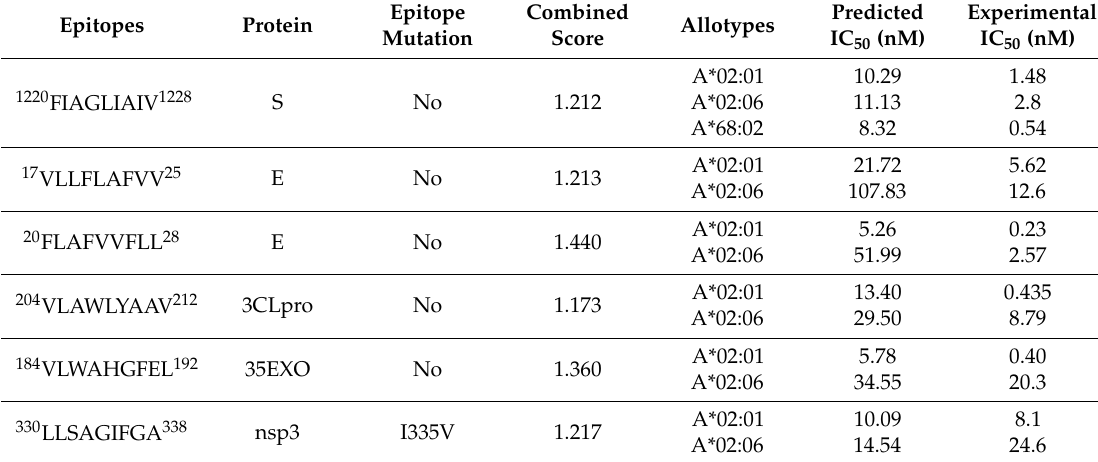
Table 3. SARS-CoV-2–derived HLA-A*02 supertype-binding epitopes that are identical to the epitopes of SARS-CoV strains experimentally known to activate cytotoxic T-cells. Epitopes Protein